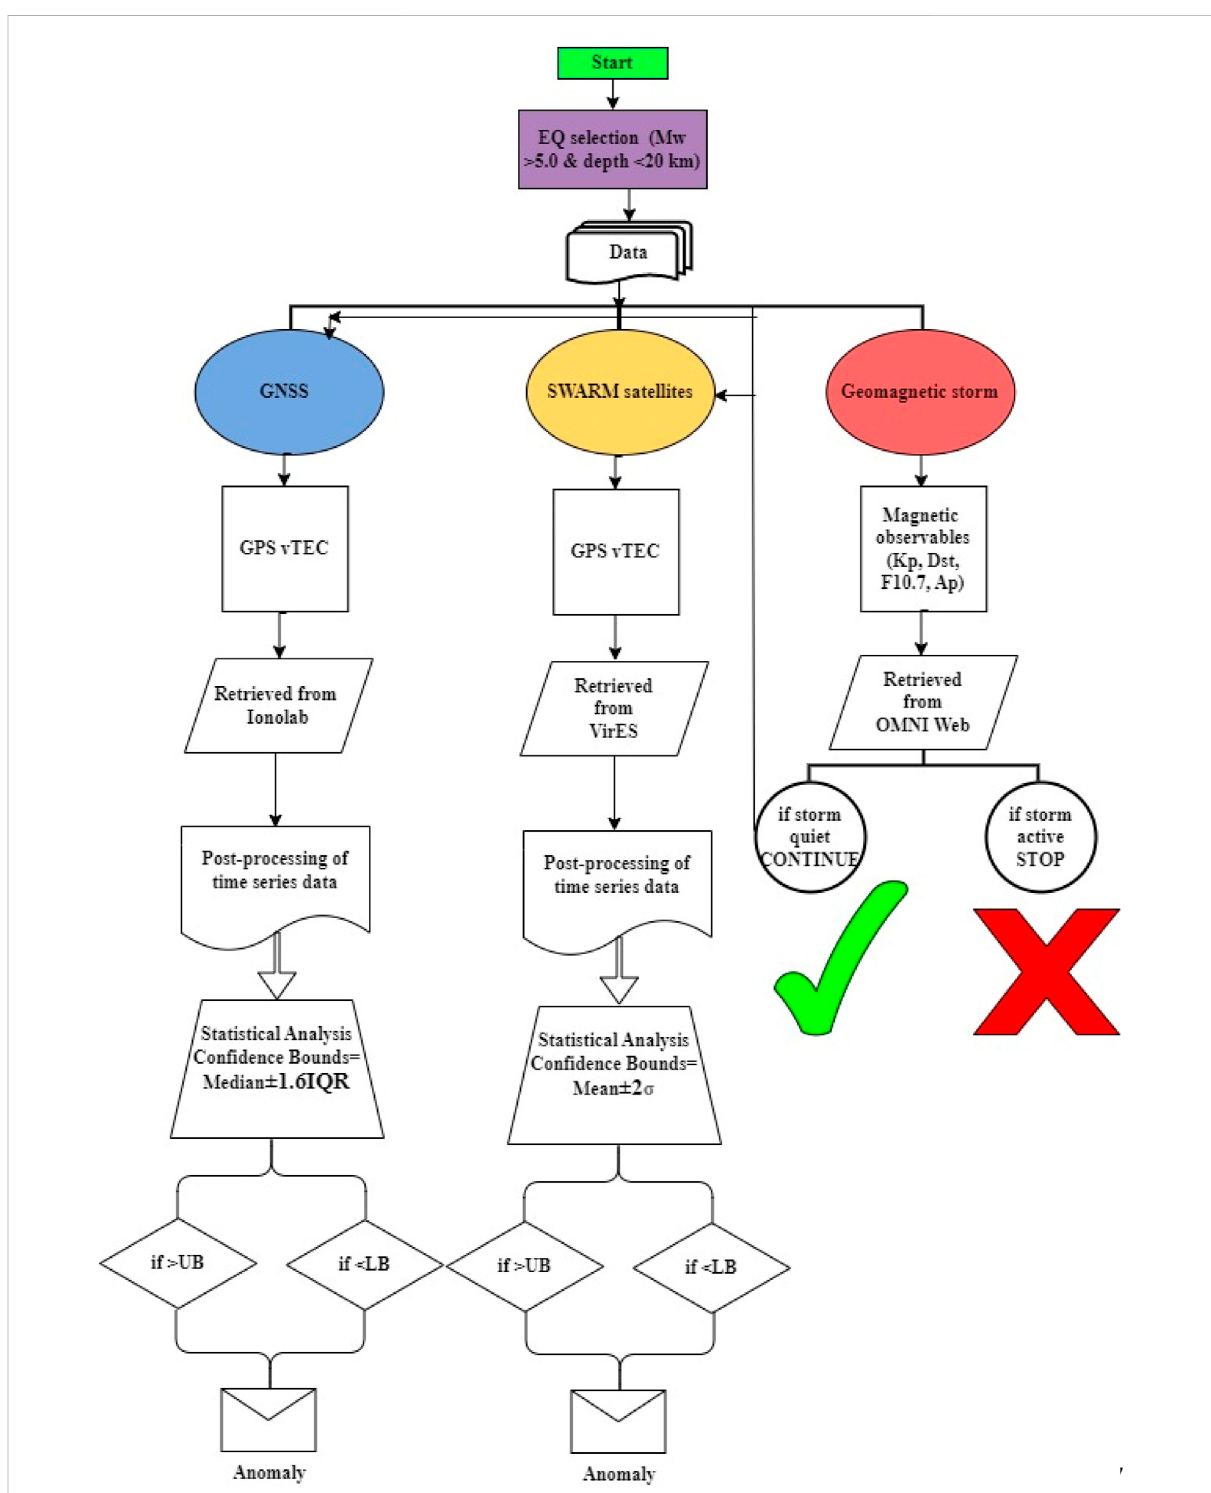
FIGURE 2 Complete fl ow chart for the observation of seismo-ionospheric anomalies. It is only applicable to EQs during quiet storm conditions.